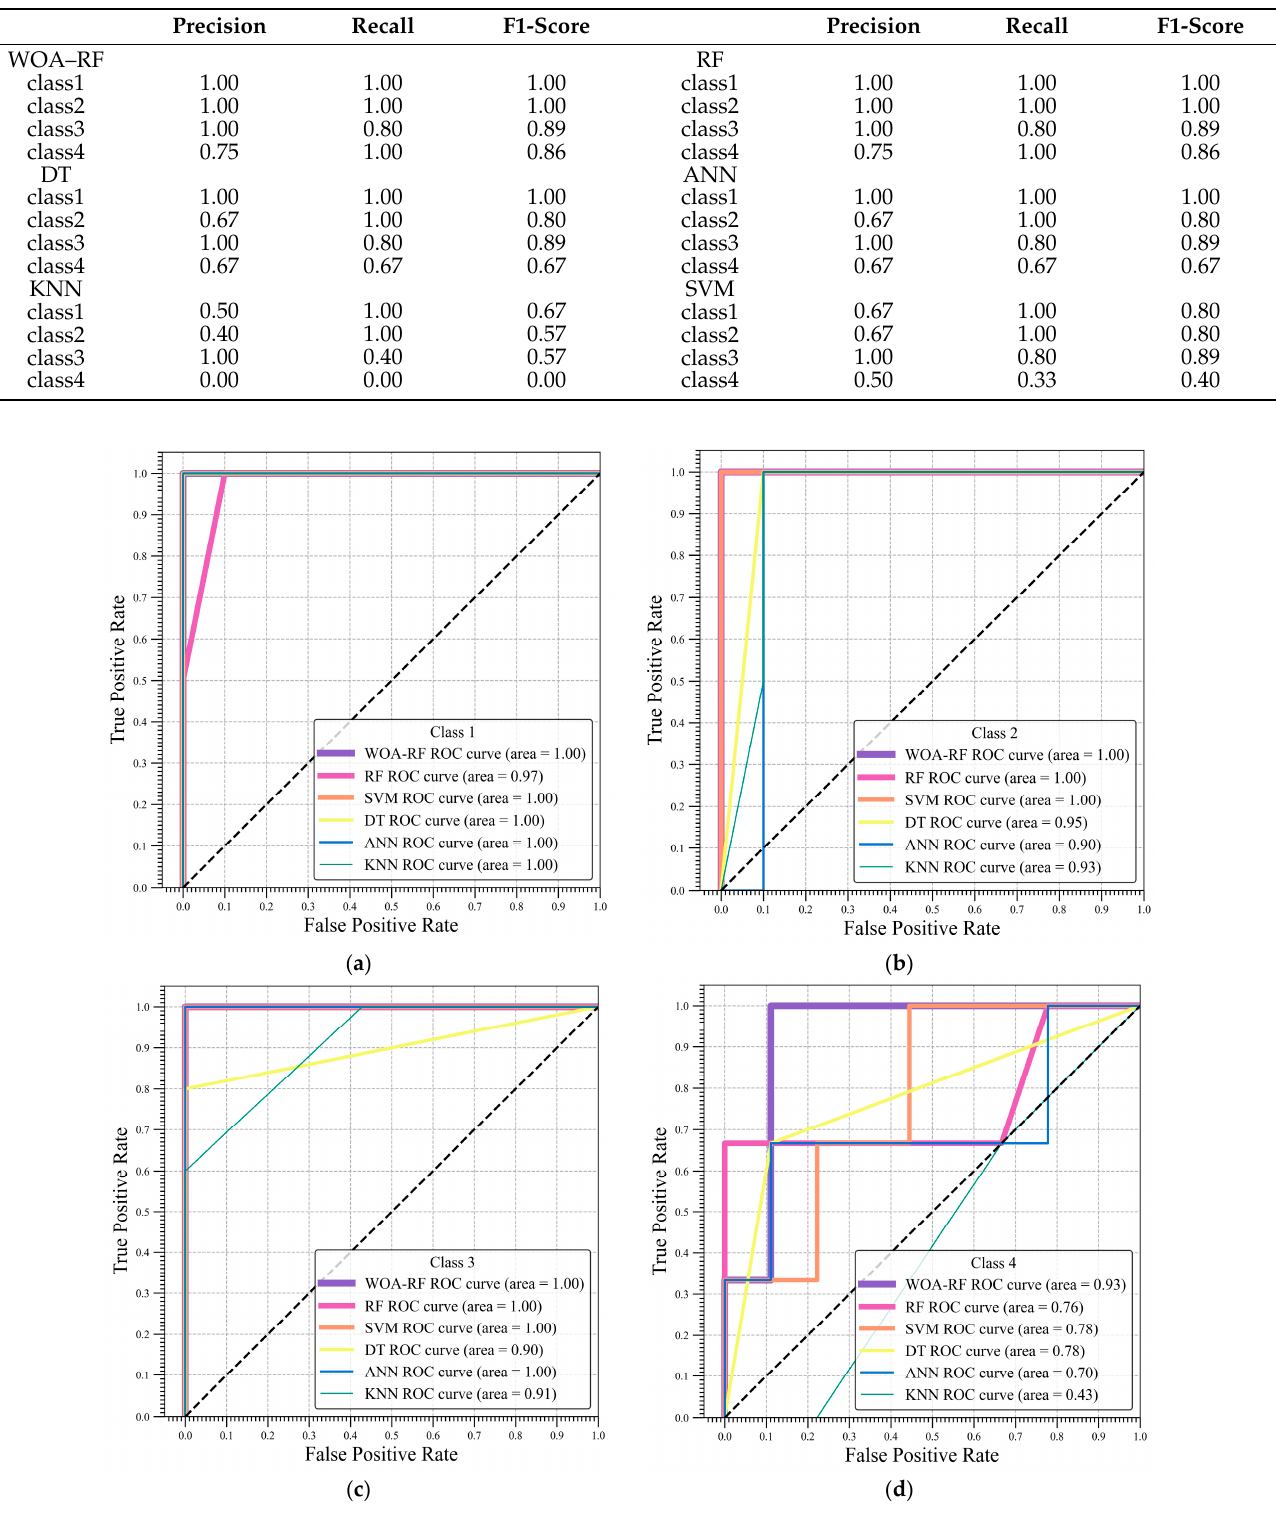
Table 3. Testing performance of different classifiers for the invalidation risk of the backfilling pipeline problem: extremely dangerous (Class 1), significant risk (Class 2), greater risk (Class 3), and general risk (Class 4).